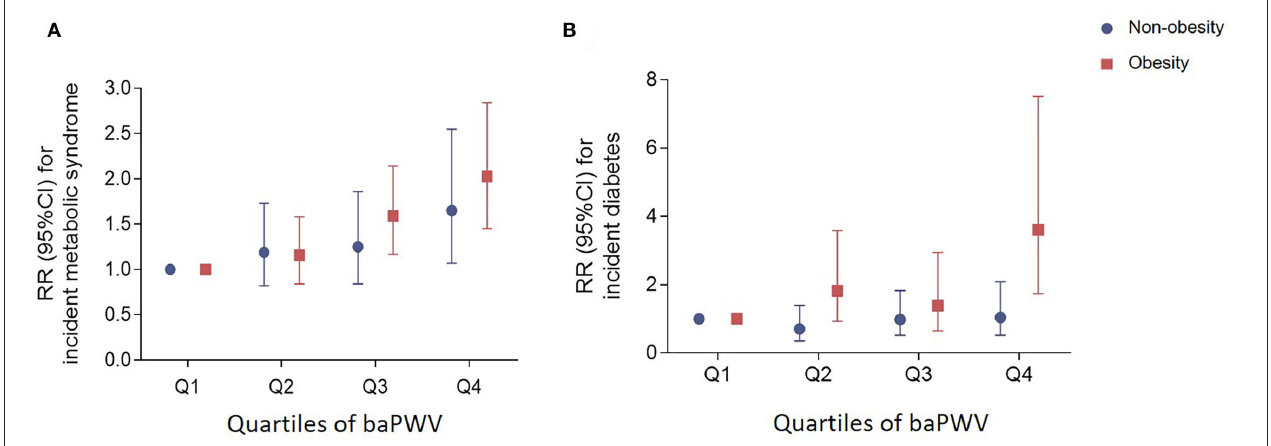
FIGURE 2 | RRs (95% CIs) of incident metabolic syndrome (A) and diabetes (B) according to baPWV in non-obese and obese participants. Adjusted for age, sex, current smoking (yes/no), current drinking (yes/no), education, physical activity, SBP, BMI, LDL-C, and FPG. RR, risk ratio; CI, confidence interval; baPWV,